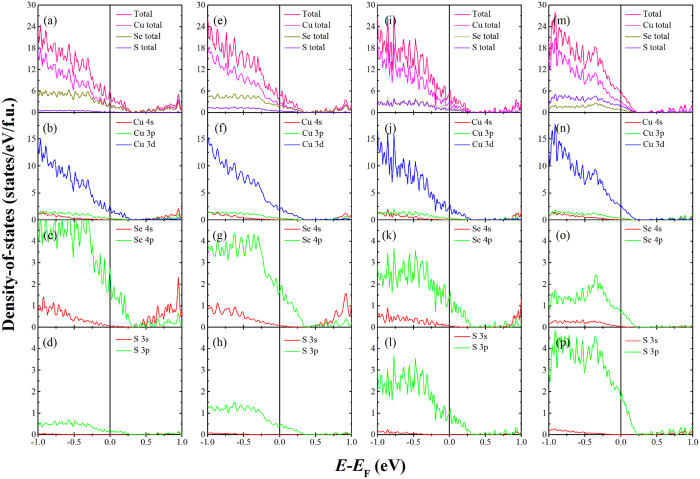
Calculated total and partial density-of-states (DOS) for the Cu15SxSe8−x (x = 1, 2, 4, 6) compounds obtained from the Density Functional Theory calculations.(a,b,c,d) total and partial DOS for the Cu15S1Se7. (e,f,g,h) total and partial DOS for the Cu15S2Se6. (i,j,k,l) total and partial DOS for the Cu15S4Se4. (m,n,o,p) total and partial DOS for the Cu15S6Se2. The total DOS for the Cu, Se, and S atoms are displayed, and the partial DOS for the 4s-, 3p-, and 3d-states of Cu, the 4s- and 4p-states of Se, and the 3s- and 3p-states of S are also presented. The vertical lines mark the position of the Fermi level (EF).